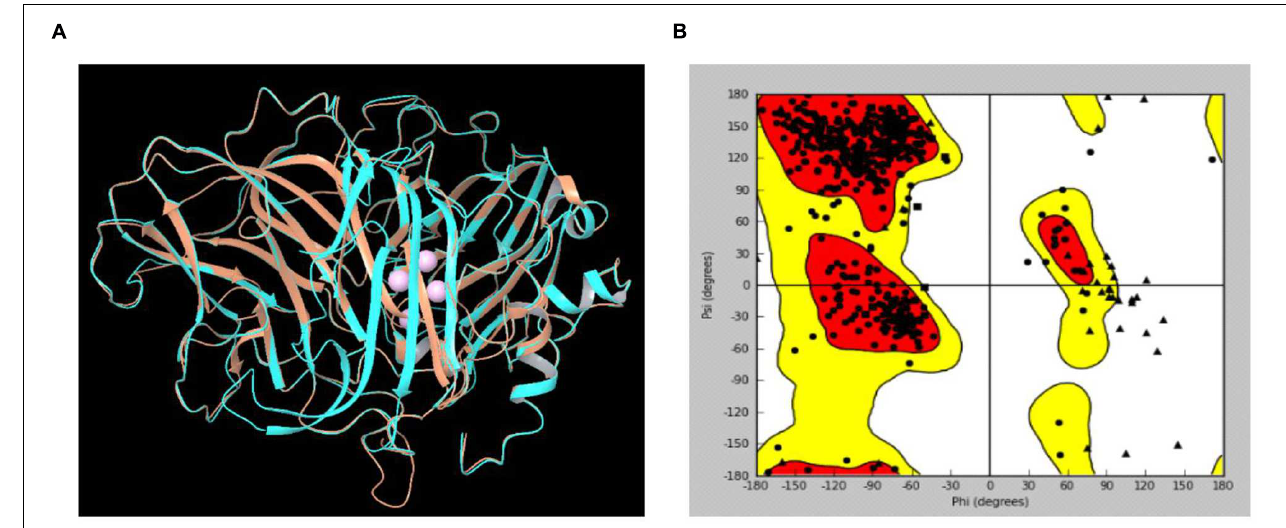
FIGURE 9 | (A) Superimposed view of structural alignment between the laccase-1 model of Agaricus bisporous and PDB:3KW7_A [Cyan: laccase-1 model; Brown: 3KW7_A with four Cu ions in pink]; (B) Ramachandran Plot for laccase-1 model.